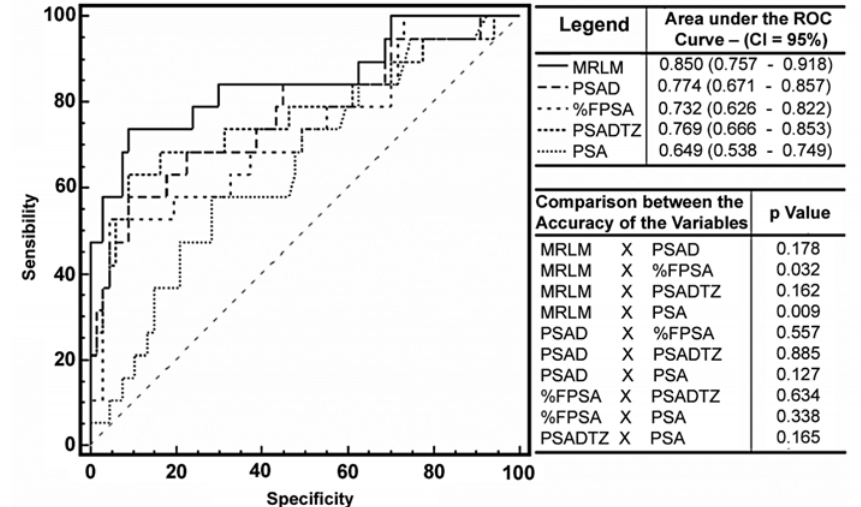
Figure 4 – Receiver Operating Characteristic (ROC) curve and comparison between the areas bellow the ROC curve (accuracy) produced by the multivariate logistic regression model (MLRM), PSA density (PSAD), percentage of the free PSA (%FPSA), PSA Density in the Transition Zone (PSADTZ) and PSA in the 95 patients with digital rectal examination with non suspicion for